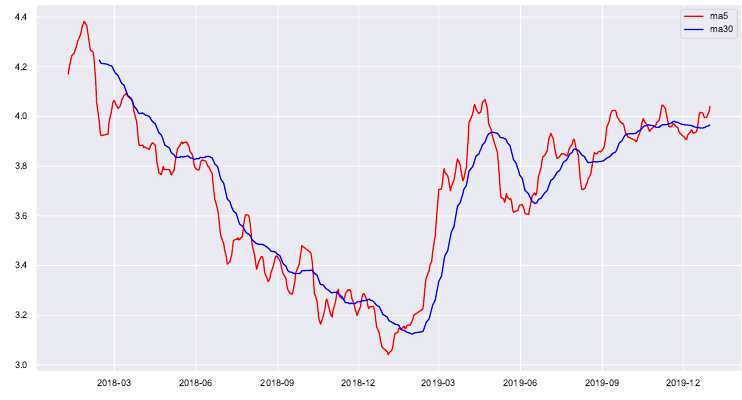
Figure 6. Changes in the double average